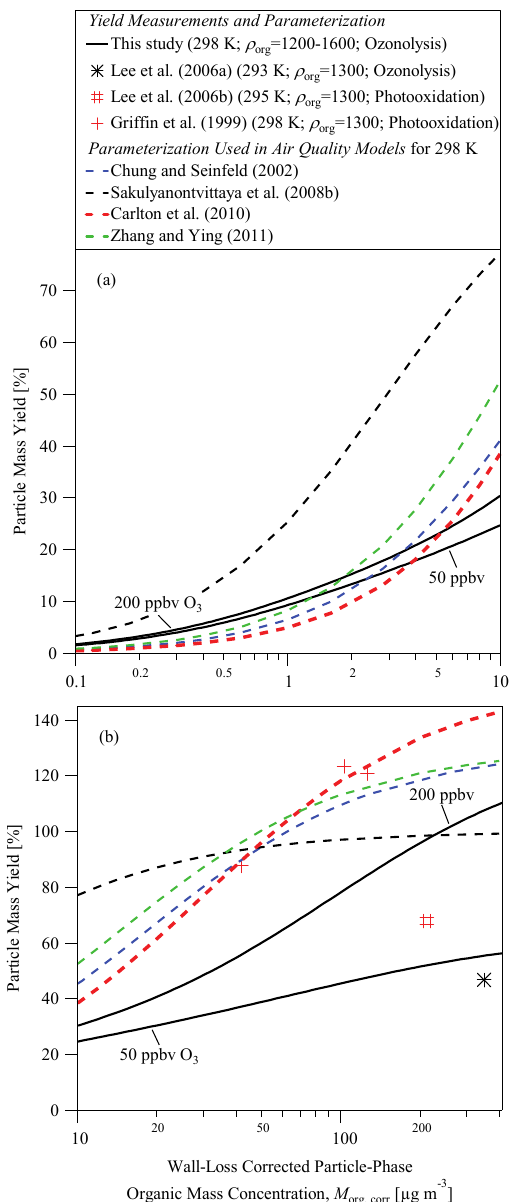
Fig. 7. Comparison of particle mass yields parameterized in this study to those reported in the literature for β -caryophyllene ox- idation. Panel (a) shows the data in the atmospherically rele- vant range of organic particle mass concentration (0.1–10µgm − 3 ) . Panel (b) shows the data over an extended range of organic particle mass concentration (10–400µgm − 3 ) . A material density ρ org of 1300kgm − 3 was assumed to convert the volume-based data sets of Lee et al. (2006a) and Griffin et al. (1999) to mass-based data sets. This density corresponded to M org , corr > 10µgm − 3 of the present study (Fig. S3). A vaporization enthalpy of 40kJmol − 1 was used for temperature compensation from 308K to 298K for the data re- ported by Griffin et al. (1999). The dashed lines show four differ- ent parameterizations that have been used in air quality and climate